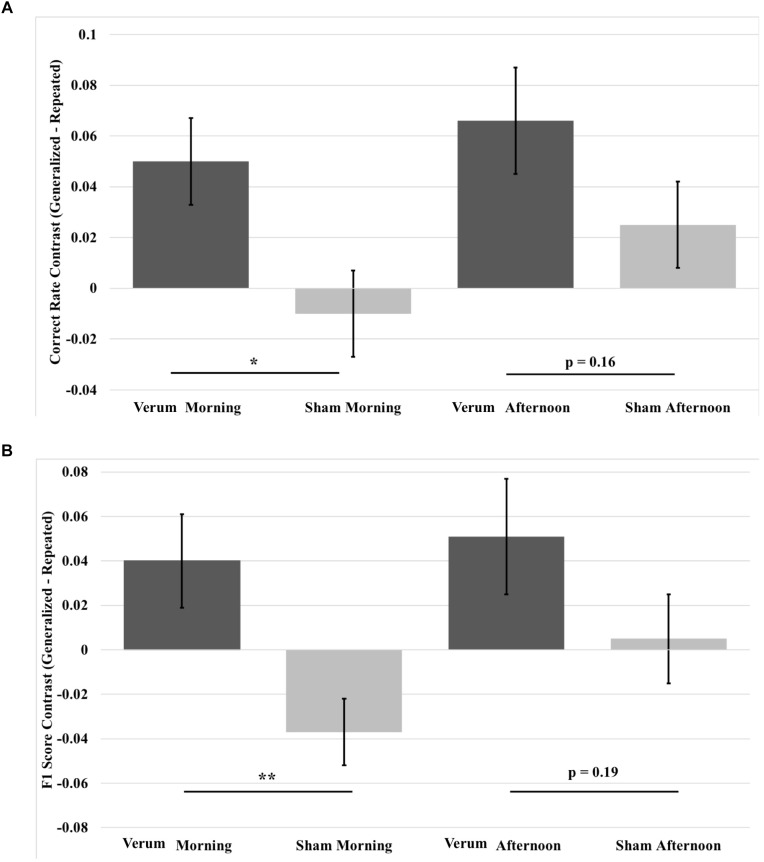
Contrast in overnight performance changes between generalized and repeated images from immediate to morning and afternoon tests in the verum and sham stimulation conditions. (A) Generalized vs. repeated image contrast in overnight correct rate changes. The overnight correct rate change for generalized images over that for repeated images was significantly greater for verum stimulation compared to sham stimulation at the morning test. This difference was at a trend level at the afternoon test. (B) Generalized vs. repeated image contrast in overnight F1 score changes. The overnight F1 score change for generalized images over that for repeated images was significantly greater for verum stimulation compared to sham stimulation at the morning test. This difference was at a trend level at the afternoon test. ∗p < 0.05, ∗∗p < 0.01, error bars represent ±1 SEM.